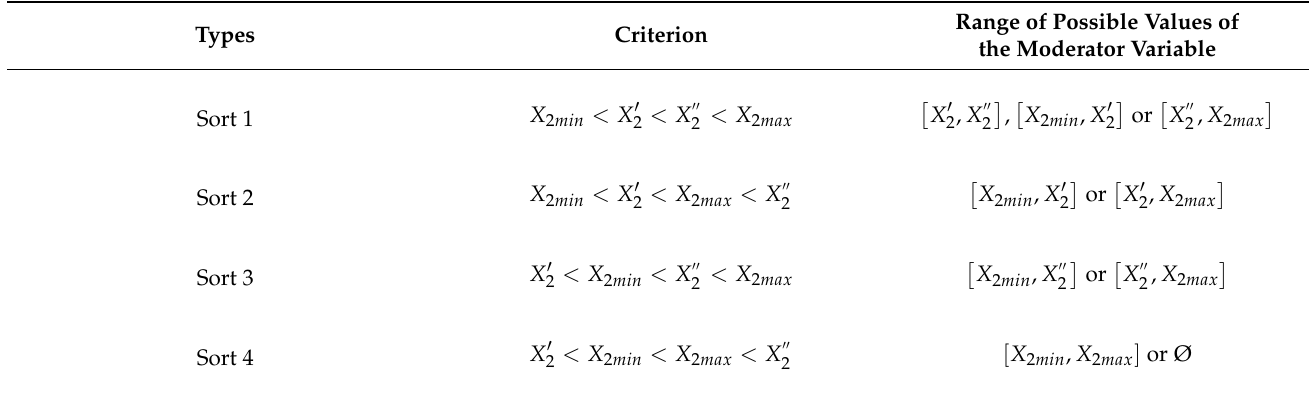
and X (cid:48)(cid:48) are the 2 2